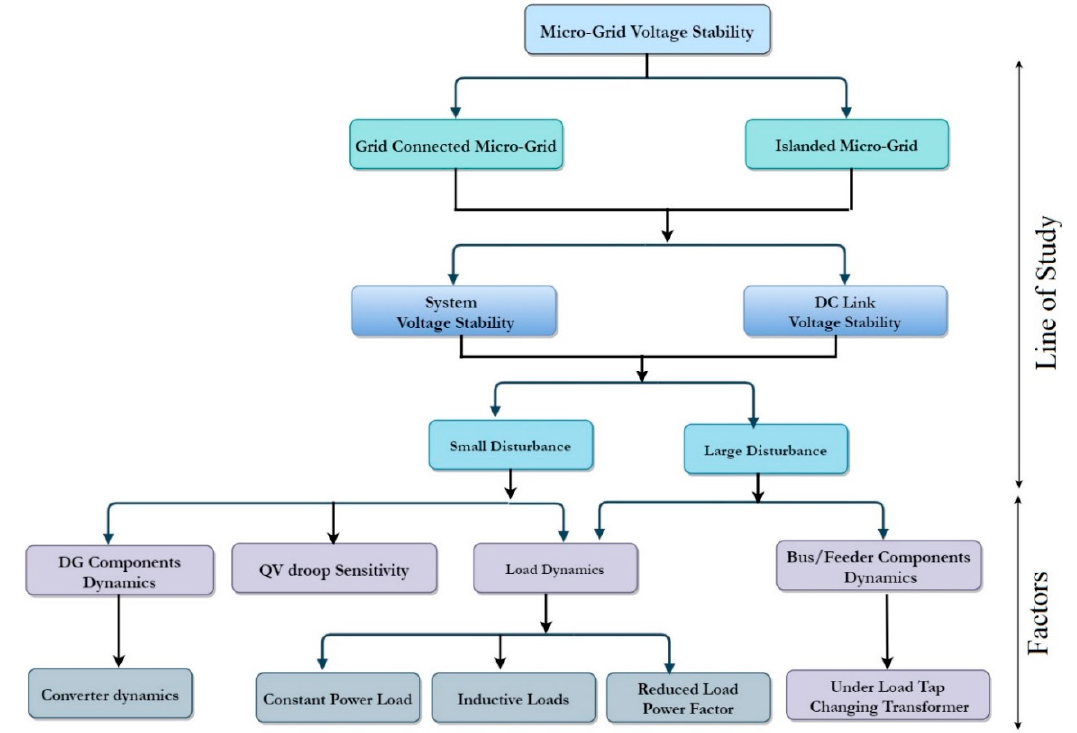
Figure 1. Study line for voltage stability in microgrids.